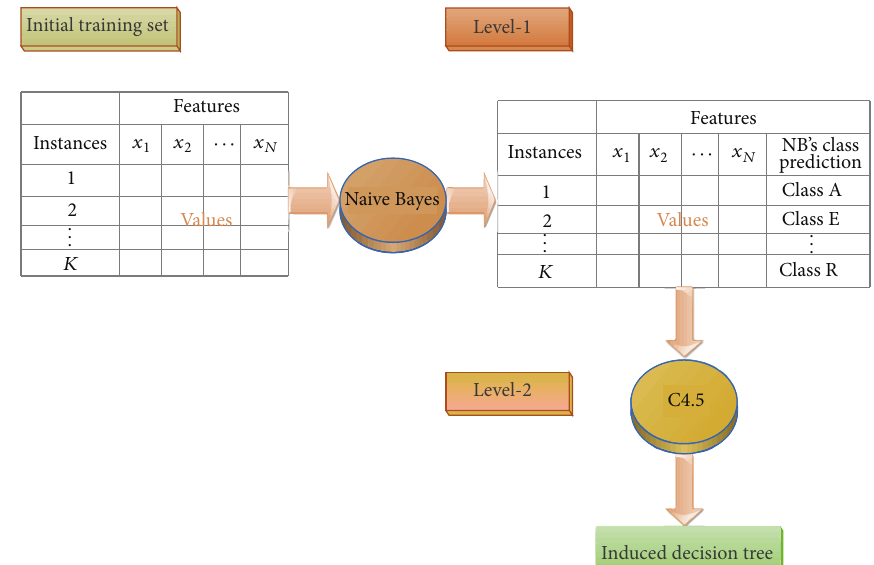
Figure 1: Cascading NB and C4.5 (NB ∇